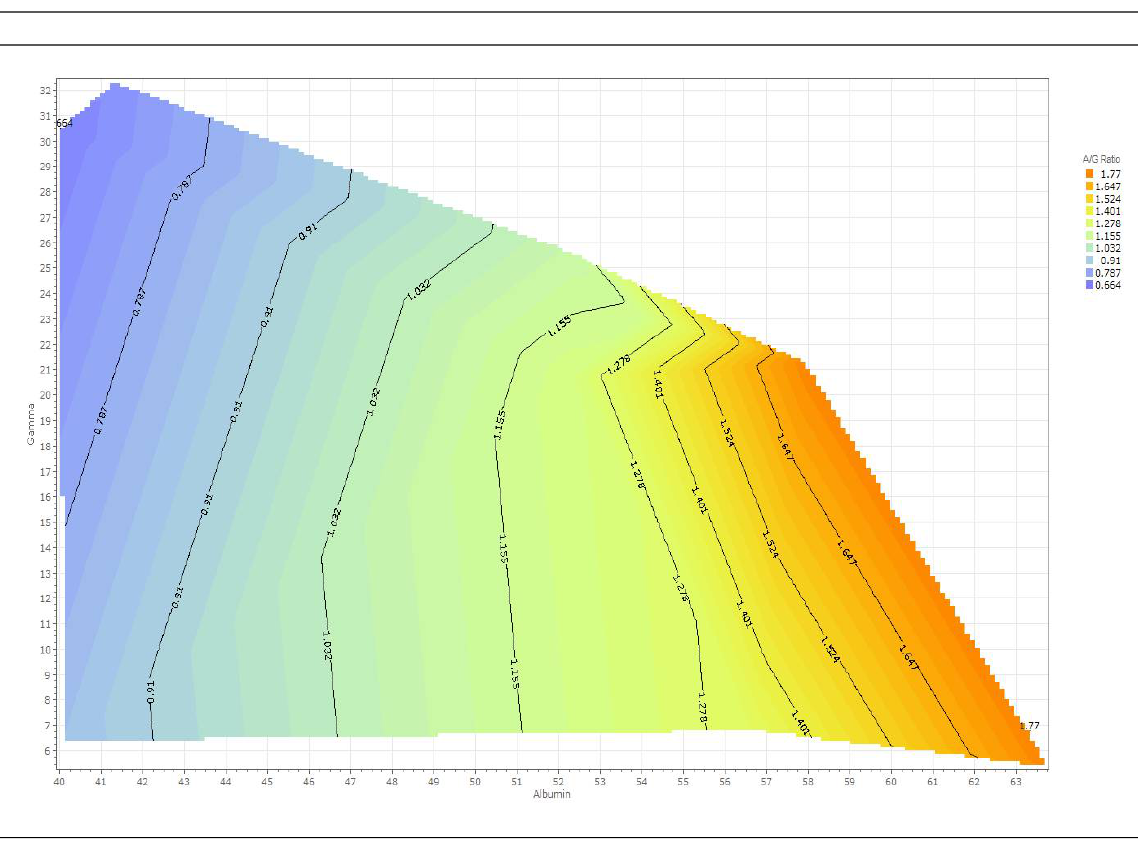
Figure 13: Variation of A/G ratio with respect to albumin and